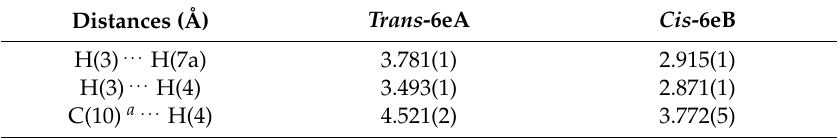
Table 3. Selected interatomic distances (Å) in esters 6eA and 6eB according to single-crystal XRD. Distances (Å)